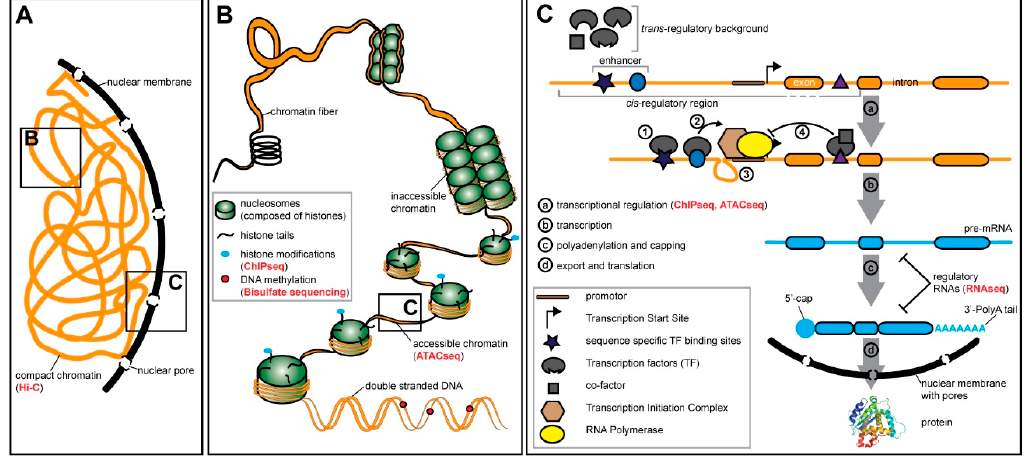
Figure 1. Gene expression is regulated on various levels. ( A ) The DNA is compressed in the nucleus of the cell. ( B ) The DNA in the nucleus is compressed by binding of histone proteins. The chromatin contains easily accessible euchromatin regions and highly compact and inaccessible heterochromatin regions. The status of the chromatin is influenced by post-translational histone modifications. Gene expression is modulated by the chromatin state and DNA modifications, such as methylations. ( C ) Key steps of gene expression ( a – d ). Transcription factors (TFs) bind to the DNA at specific sequences ( 1 ). TF binding activates the transcription initiation complex ( 2 ) through conformation changes (looping) of the DNA ( 3 ). TFs can also repress transcription, for instance by binding of a co-factor ( 4 ). Next generation sequencing (NGS)-based methods that can be applied to study certain aspects of gene regulation are mentioned in red in brackets. See Table 1 for an overview of the methods mentioned here.